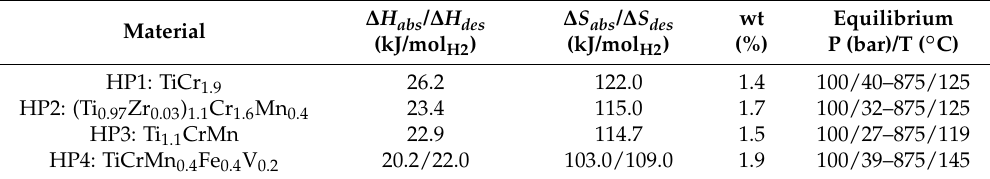
Table 1. Thermodynamic properties, weight capacity, and equilibrium conditions of the four downselected high-pressure metal hydrides (HP1, HP2, HP3, and HP4). The values of absorption and desorption reaction enthalpy ( ∆ H abs and ∆ H des ), absorption and desorption reaction entropy ( ∆ S abs and ∆ S des ) and material weight capacity ( wt ) are shown.